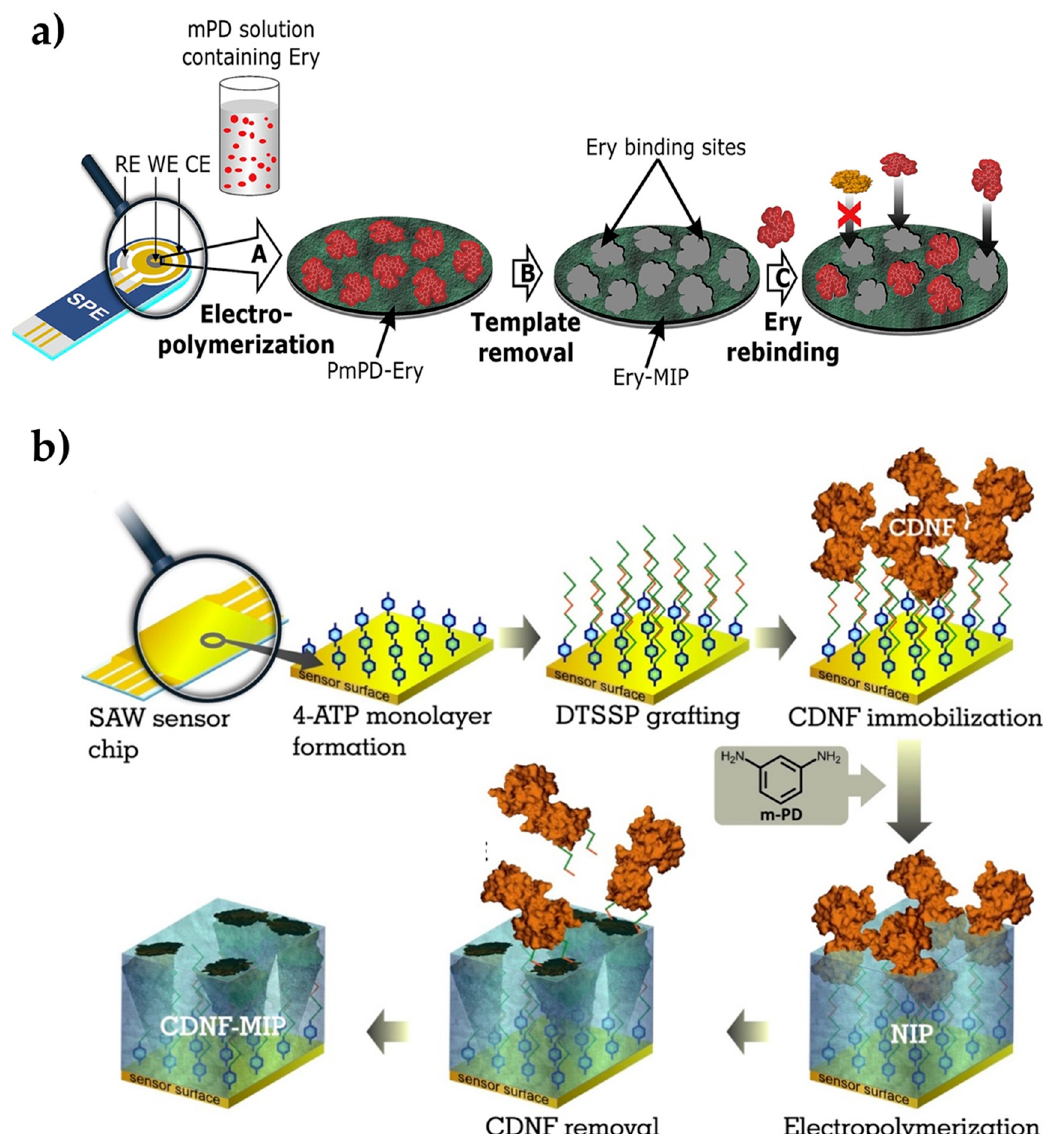
Figure 3. Preparation of the erythromycin-imprinted electrochemical sensor ( a ) and cerebral dopamine neurotrophic factor protein-imprinted surface acoustic wave sensor ( b ). Republished with permission from Ayankojo et al. and Kidakova et al. [87,88].